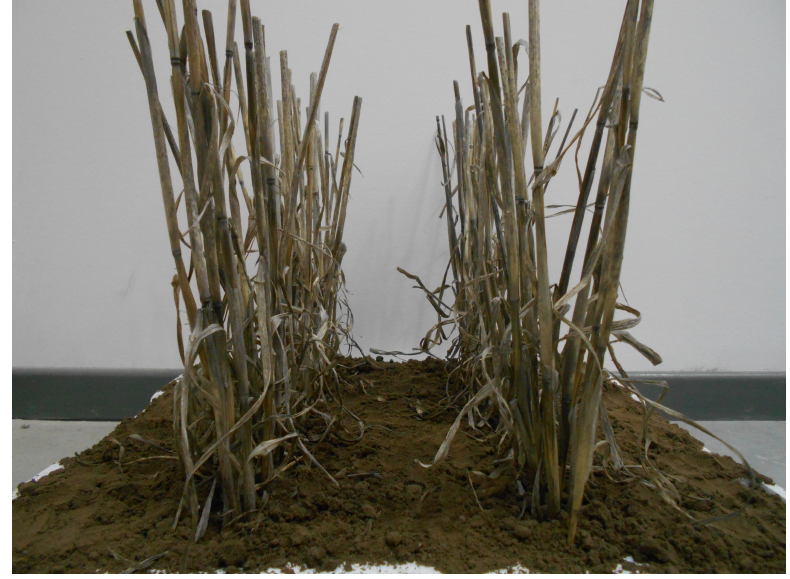
Figure 5. Wheat stubble